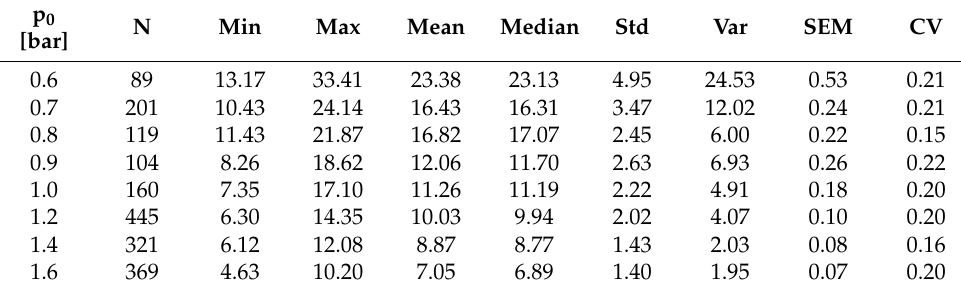
Table 4. Statistical description of the equivalence ratio Φ = 1.25 case presented in Figure